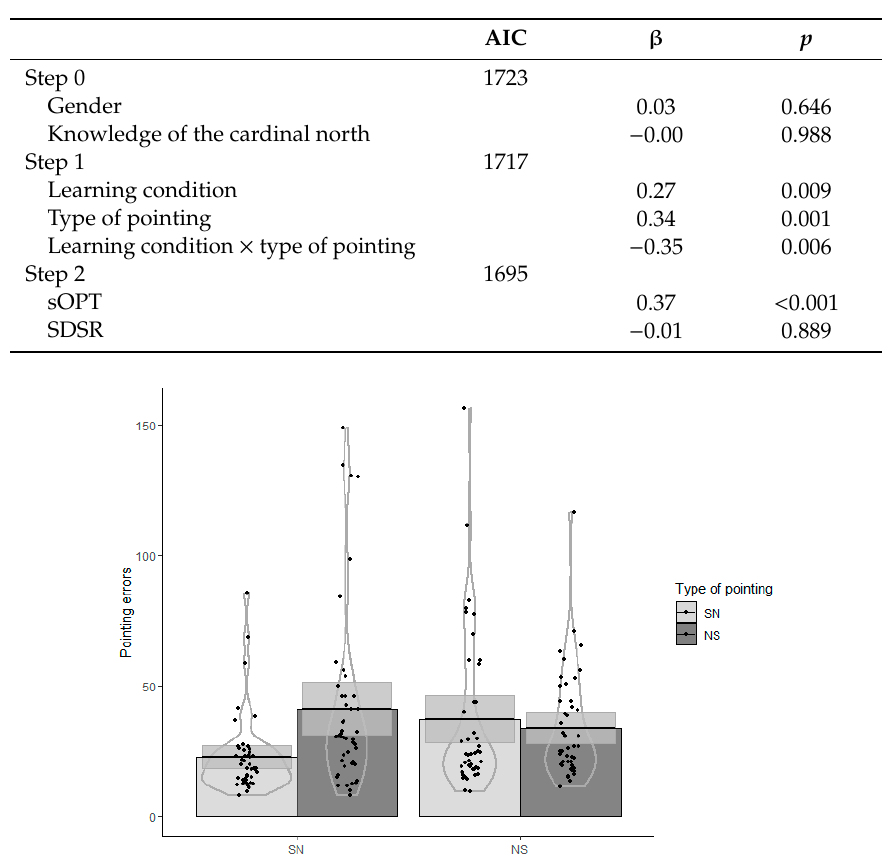
Table 2. Pointing task. Steps in the linear regression models with AIC (Akaike Information Criterion), predictors β and p-values.